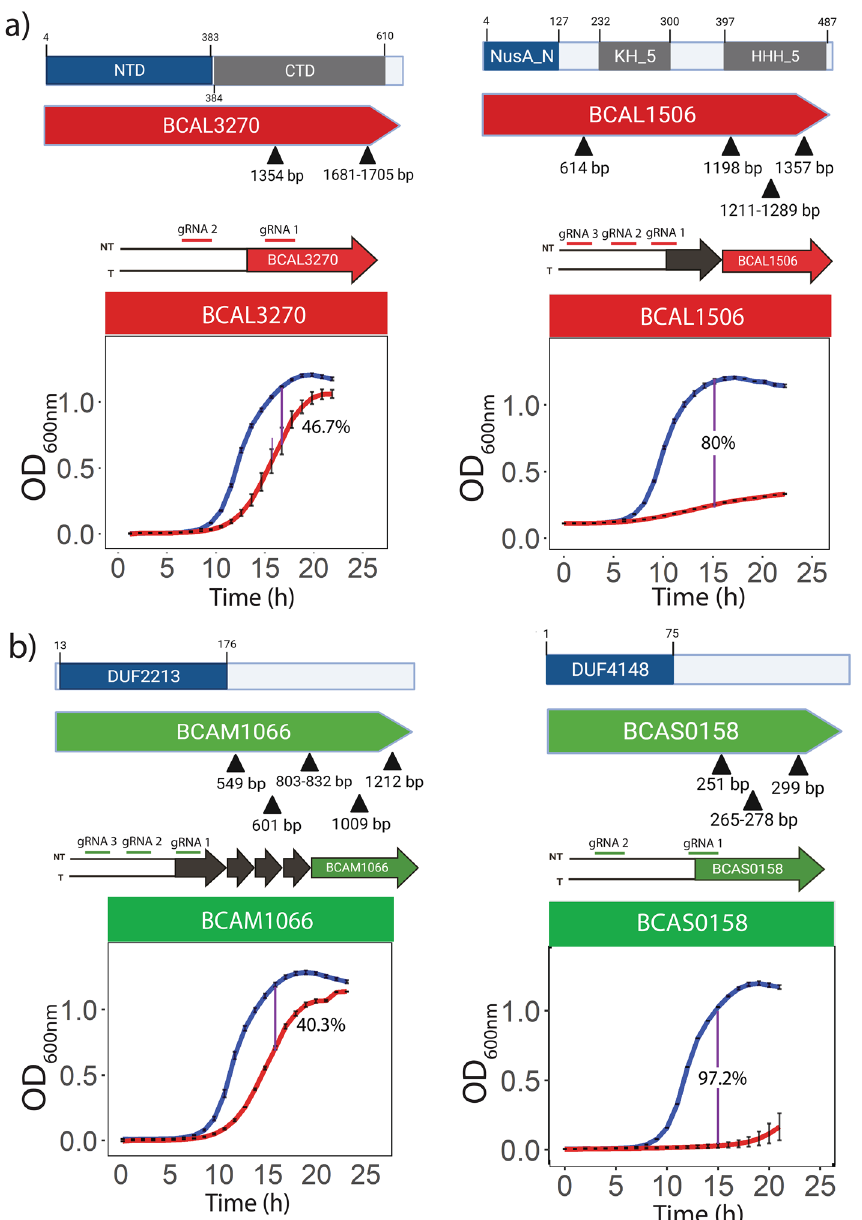
Figure 3. Biased transposon insertion identifies putative essential domains of uncharacterized hypothetical proteins. Tn-seq reads from 17 were mapped to the B. cenocepacia K56-2 genome and predicted to contain essential domains. ( a ) The script identified the well characterized essential N-terminal domains of DnaK (BCAL3270) and NusA (BCAL1506). Their respective CRISPRi mutants demonstrated a conditional growth defect. ( b ) Two uncharacterized genes BCAM1066 (WQ49_RS16145) and BCAS0158 (WQ49_RS10495) contain the Pfam domains DUF2213 (PF09979) and DUF4148 (PF13663), respectively, at the N-terminal end. The Tn-seq reads map to the C-terminal end of these genes, demonstrating the essentiality of DUF2213 and DUF4148. Putative essential domains are highlighted in blue. Black triangles represent the transposon insertion sites. Numbers on top of the domains denote amino acid sequence positions. Blue and red lines in the growth curves ( a and b ) represent growth in the absence and presence of rhamnose, respectively. Growth curves are shown for the most efficient sgRNAs. Growth curves values are the average of three independent biological replicates. Error bars indicate mean ±